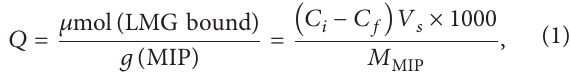
F 1: Binding isotherm for LMG/MAA and LMG/AAMPSO imprinted polymer C; = 10.0mL; binding time: 20h. (A2) Scatchard plot to estimate the binding characteristic of LMG corresponding polymer; imprinted ∘ 𝑉𝑉 𝑡𝑡 𝑡 𝑡𝑡